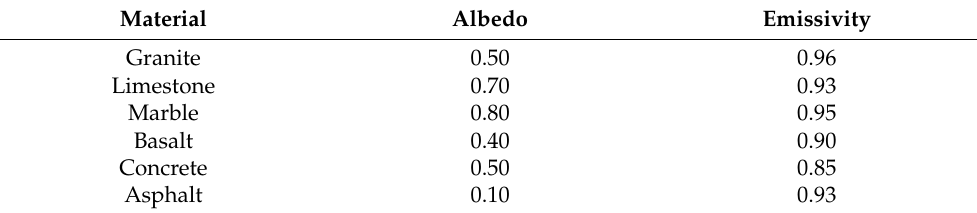
Table 1. Emissivity and albedo coefficients of building materials.